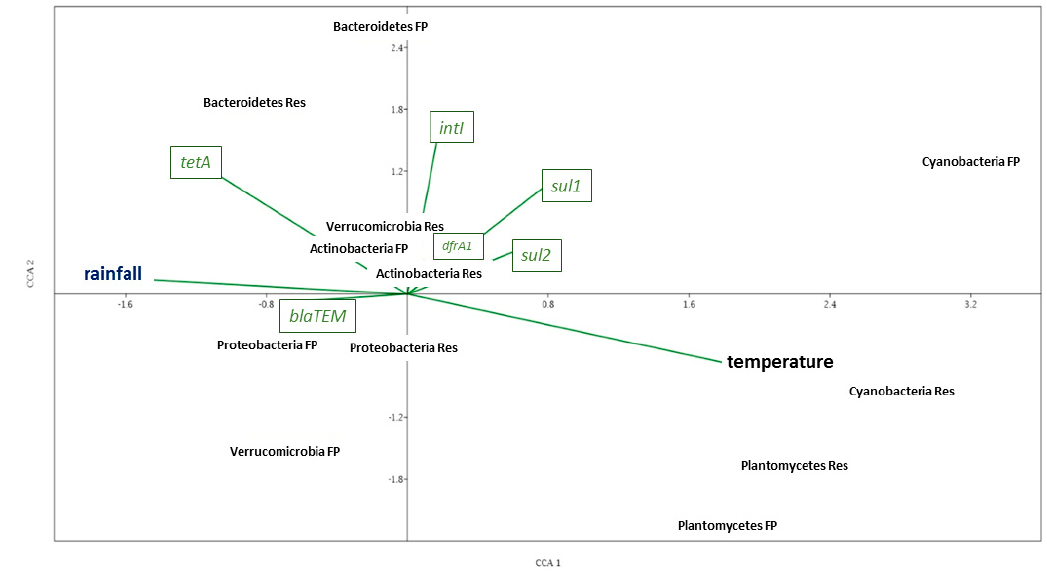
Figure 7. Canonical Correspondence Analysis (CCA) depicting the correlation between environmental factors (bold letters), ARGs (green text boxes) and prominent bacterial phyla.